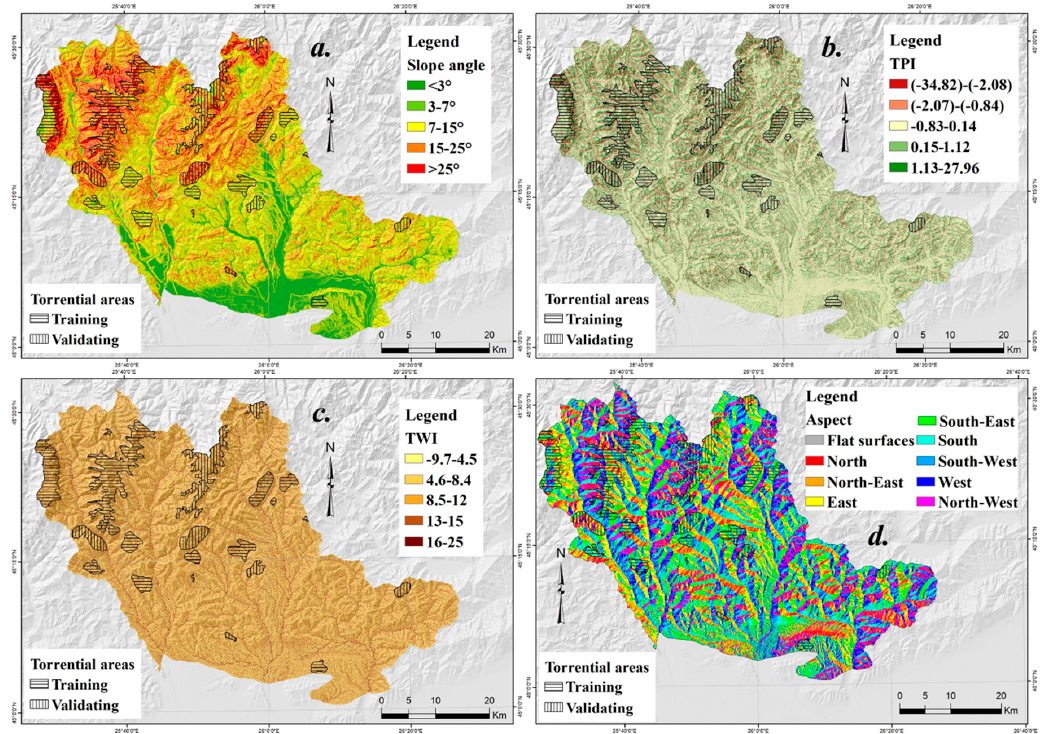
Figure 3. Flash-flood conditioning factors ( a ) slope angle; ( b ) topographic position index (TPI); Figure 3. Flash ‐ flood conditioning factors ( a ) slope angle; ( b )topographic position index (TPI); ( c ) topographic wetness index (TWI); ( d ) ( c )topographic wetness index (TWI); ( d ) aspect).